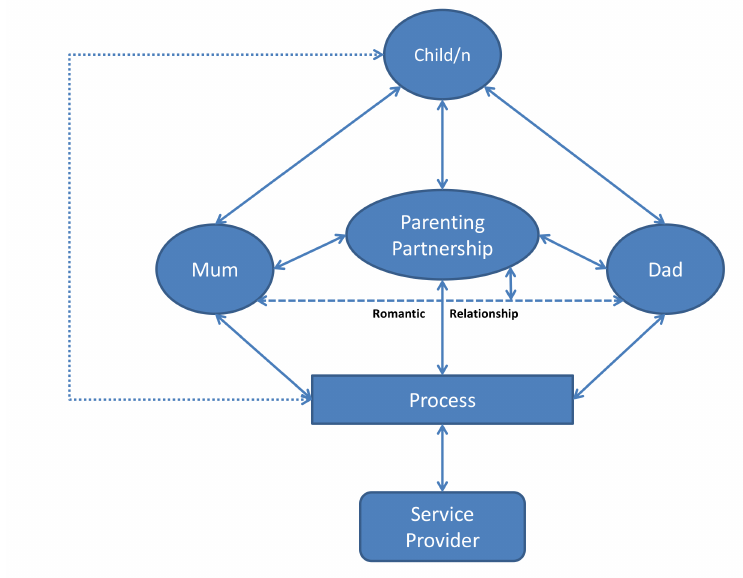
Figure 2. An interactive effects model of intervention in family